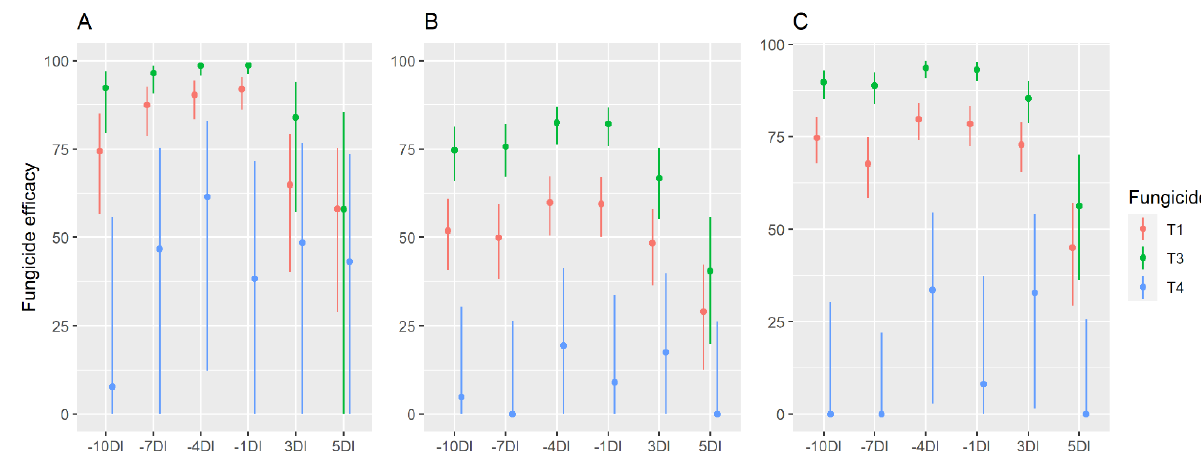
Figure 3. Efficacy of fungicide treatments applied at different times relative to the artificial inoculation of Fusarium graminearum in reducing FHB incidence ( A ), FHB severity ( B ), and DON concentration ( C ) in EXP2. Fungicides were applied 10, 7, 4, or 1 day before, or 3 or 5 days after inoculation (DI). Fungicide treatments were grouped as follows: T1 (DMI), T3 (DMI + SDHI), and T4 (MBC) (Tables 1 and 2). Bars indicate 95% confidence intervals calculated by the GLMM.